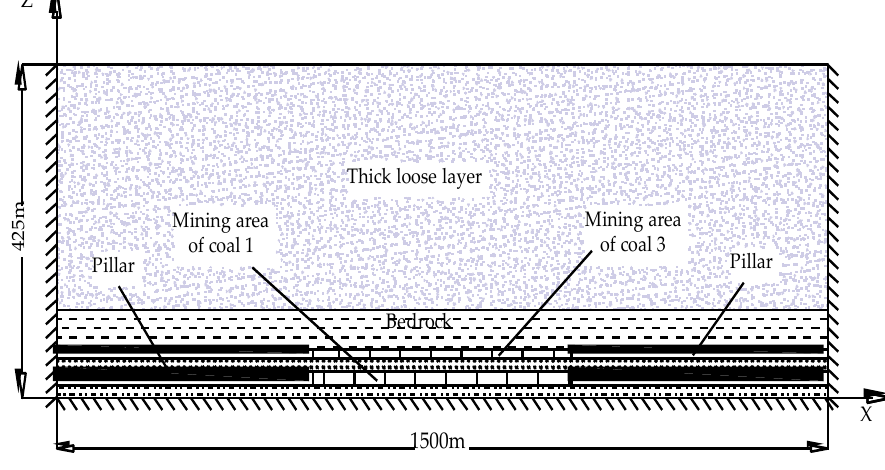
Figure 10. Geometric dimensions and boundary conditions.